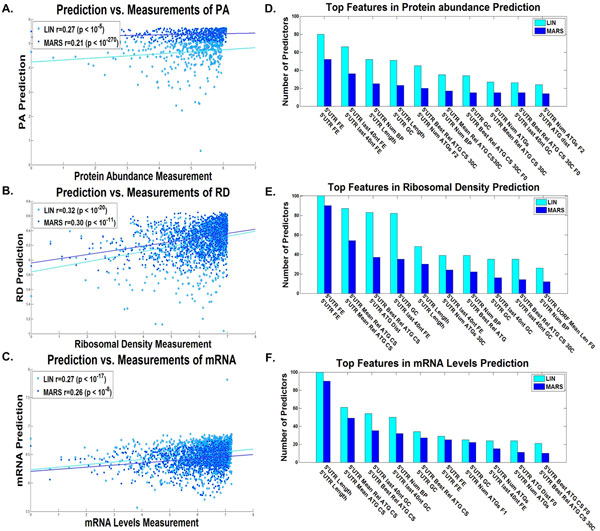
5'UTR linear and non-linear predictors results. Dot plot of the predictions vs. measurements for the validation set of the predictor with the median results for the A. protein levels, B. ribosomal densities, C. mRNA levels, for the 5'UTR linear (LIN) and non-linear (MARS) predictors (Additional file 1: Supplementary Methods). The best features according to the number of predictors they participated in (Additional file 1: Supplementary Methods) of the D. protein levels predictor, E. ribosomal density predictor, and F. mRNA levels predictor, for the 5'UTR linear (LIN) and non-linear (MARS) predictors (Additional file 1: Supplementary Methods).